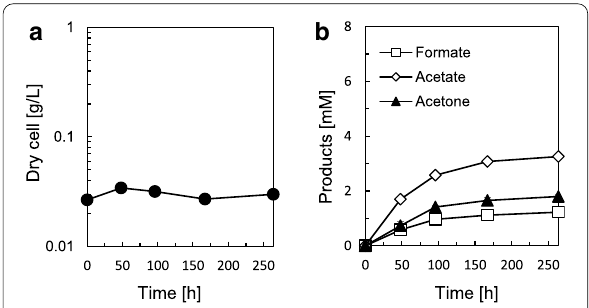
Fig. 3 Growth and metabolite profile of the pduL2::acetone strain in CO 2 –H 2 as the substrate. a Dry cell weight according to the OD. b Concentration of the excreted metabolites in the culture supernatant measured by HPLC. Data represent the mean with SDs of three biological replicates. Most error bars are smaller than the symbols of data